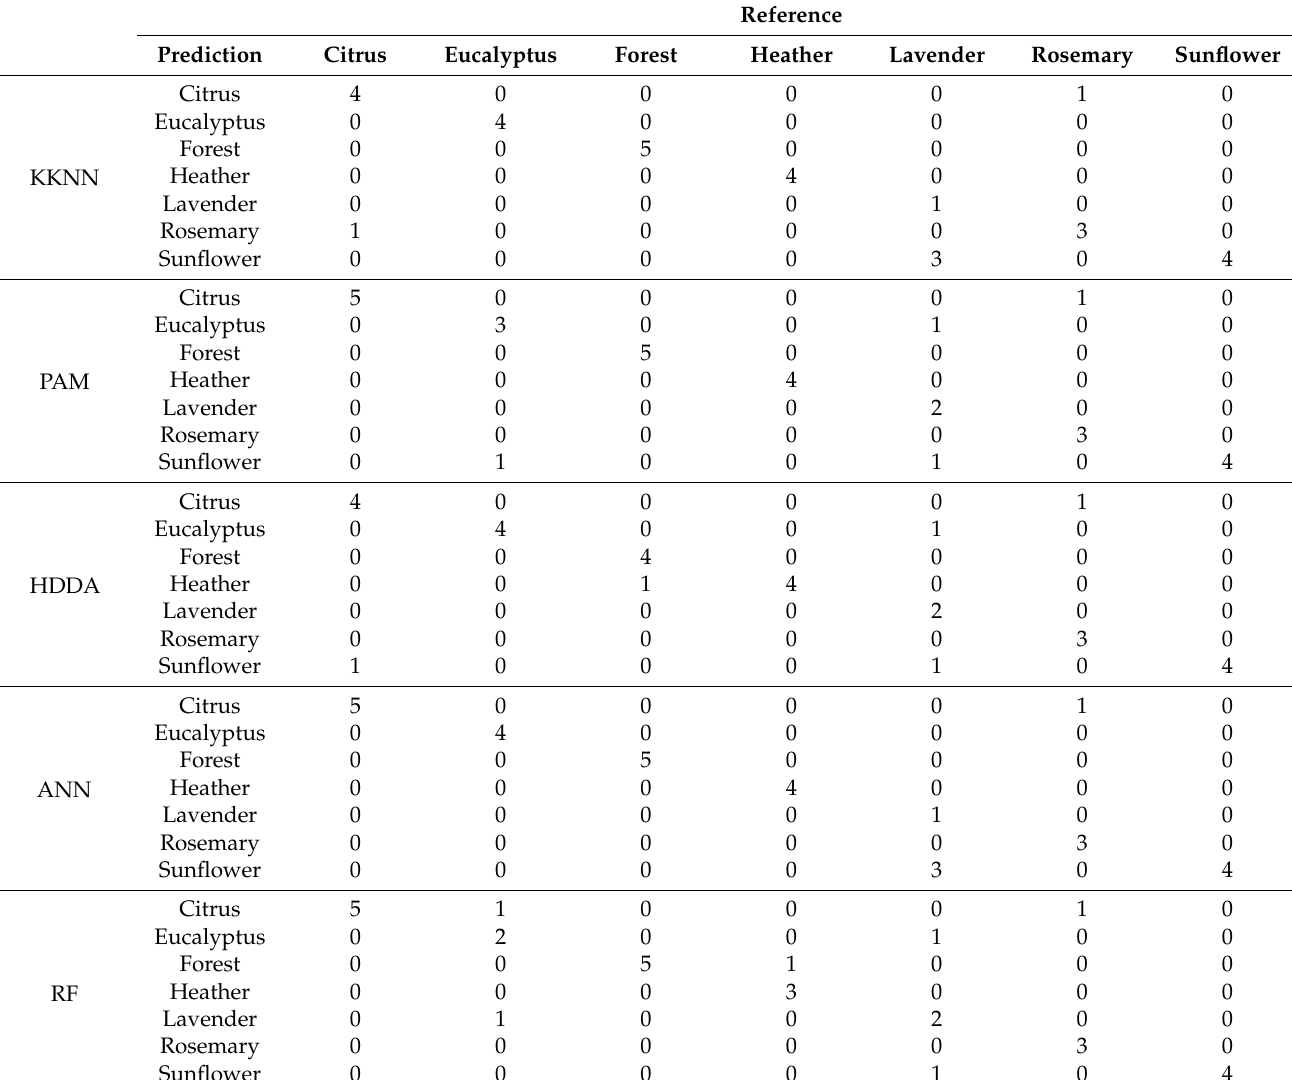
Table 3. Confusion matrices of various classifier algorithms (KKNN, PAM, HDDA, ANN and RF) on the test set. The number of honey samples was the same as that indicated in Table